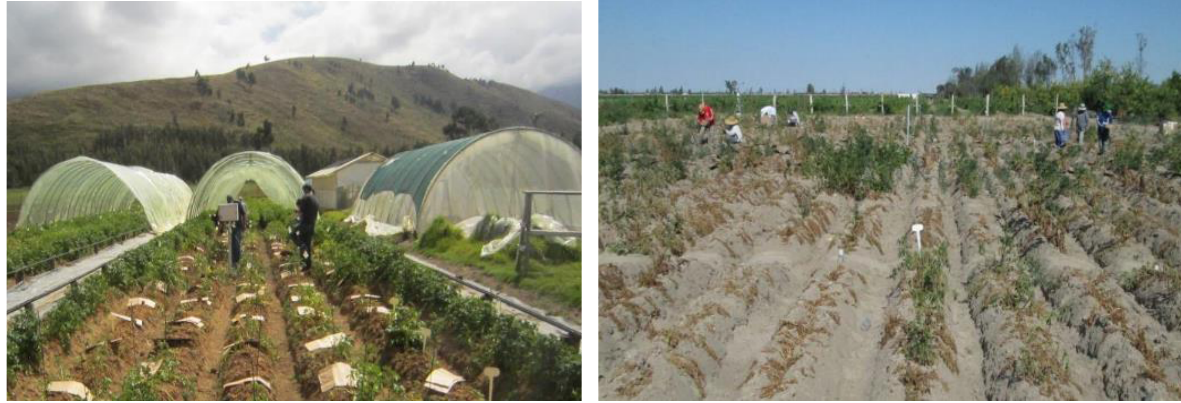
Figure 8: CIP Potato research plots in Peru (source: A. Khan, pers. comm.) Table 1: Component traits for drought tolerance (source: A. Khan, pers. comm.) Component traits